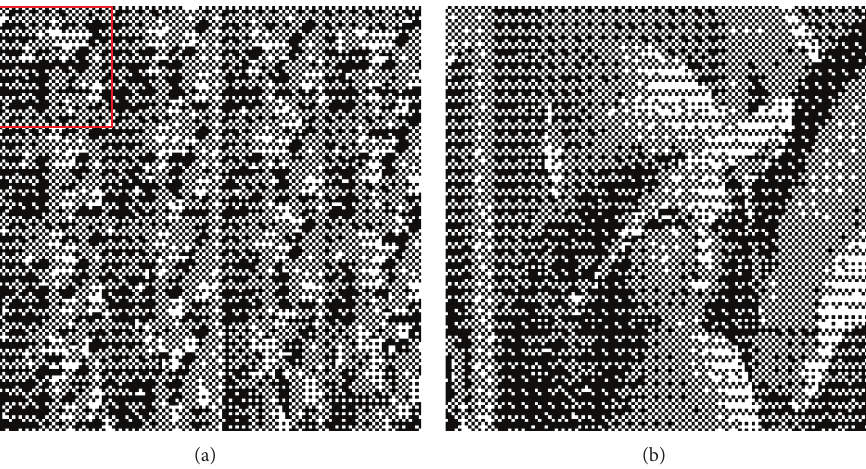
Figure 5: An example of embedding algorithm. (a) The result of embedding 120 bits into Figure 4(c). (b) The embedded dithered image by relocating